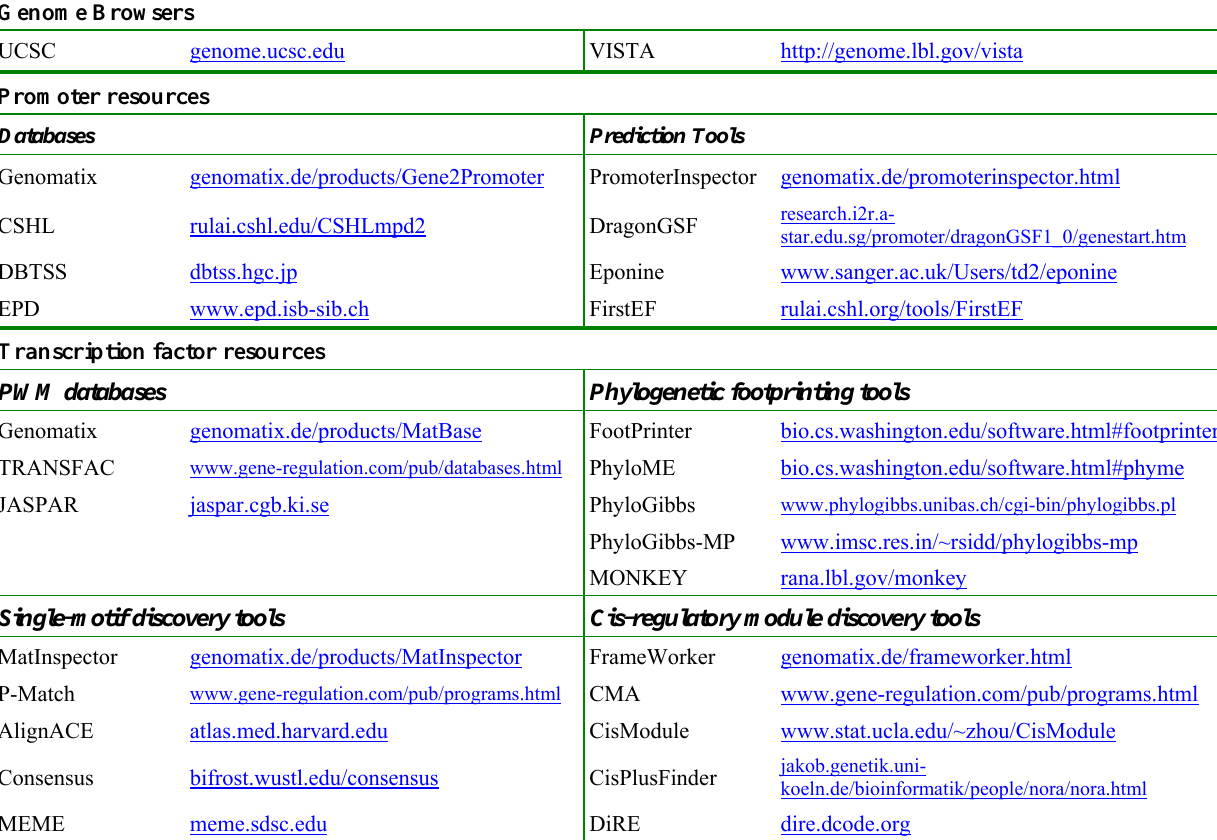
Table 1 . Selected resources and relevant tools for in silico TFBS